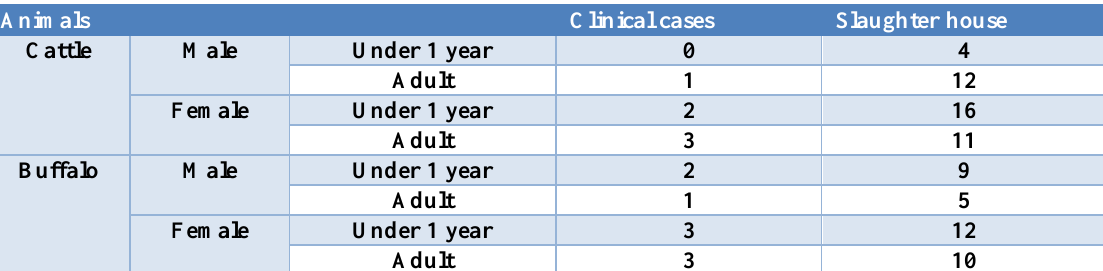
Table, 2: Numbers of clinical cases infected with HS from slaughter house according to sex of